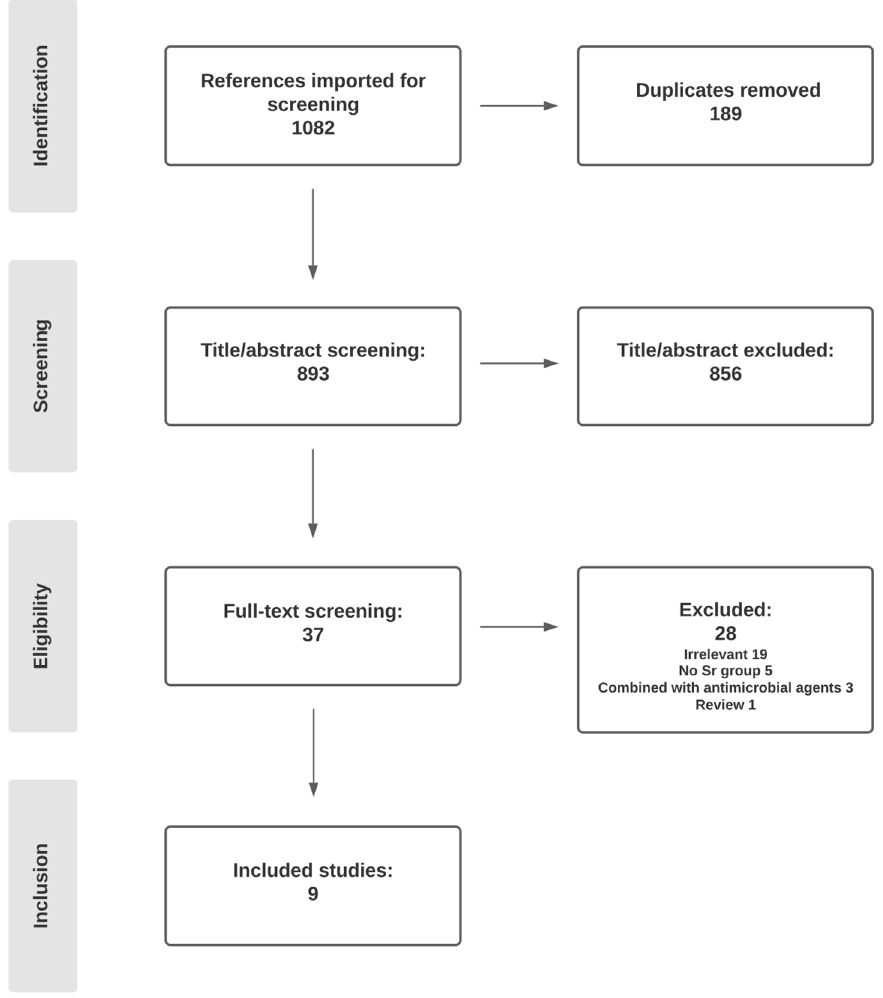
Figure 1. Flow chart of the search process and results. ‘(Titanium OR Ti OR Dental Implants OR Surfaces OR Disks OR Wafers OR Sheets) AND (Strontium OR Sr OR Metal ions OR ions) AND (Anti-Bacterial Agents OR Antibacte- rial OR Antimicrobial OR Bacteriostatic OR Bactericidal OR Viability)’. The literature search was completed manually by searching reference lists of the relevant articles for undetected studies possibly suitable for inclusion. Titles, abstracts, and full texts of the possibly relevant studies were independently screened by the two observers (HA and FB). Disagreements were resolved by discussion to reach